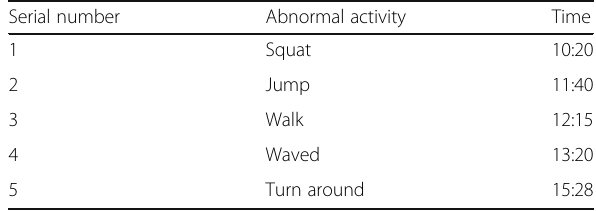
Table 3 Top five abnormal